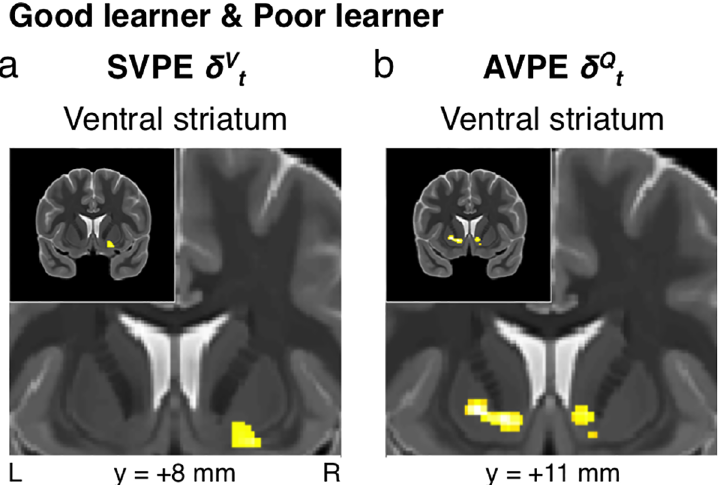
Fig 3. All performing participants: Two types of reward-prediction-error signals. (a) State-value- prediction error (SVPE) δ V t signals were observed in the ventral striatum across all performingsubjects ( p < 0.005 unc., SVC p FWE < 0.05). (b) Complementary action-value-prediction error (AVPE) δ Q t signalswere likewiseidentified in the ventral striatum ( p < 0.005 unc., SVC p FWE < 0.05). As in subsequent figures, the upper-leftcorner of each panel depicts the entire coronal section that the remainderof the respective panel zooms in on.